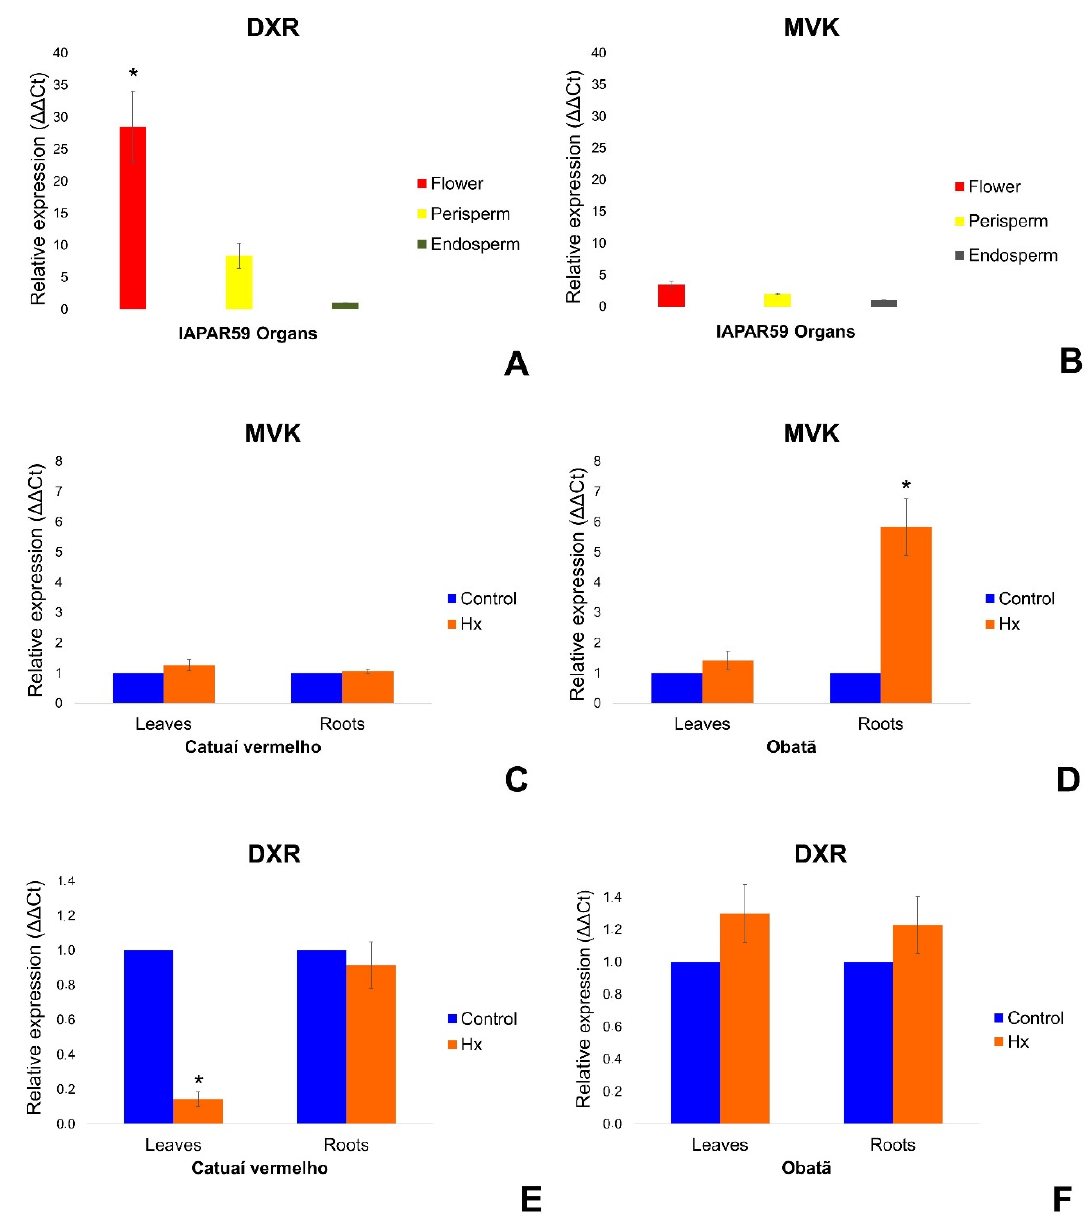
Figure 8. Transcriptional profile of CaMVK and CaDXR genes in C. arabica cv. Iapar 59 ( A and B ), C. arabica cv. Catuaí Vermelho ( C and E ) and C. arabica cv. Obatã ( D and F ). Experiments were performed using three biological and technical replicates each. Bars indicate standard deviation, and significant differences in which p < 0.05 (ANOVA followed by Tukey test) have been indicated with an asterisk (*). Abbreviations: Hexanoic acid application (Hx). Controls represent samples without Hx application.